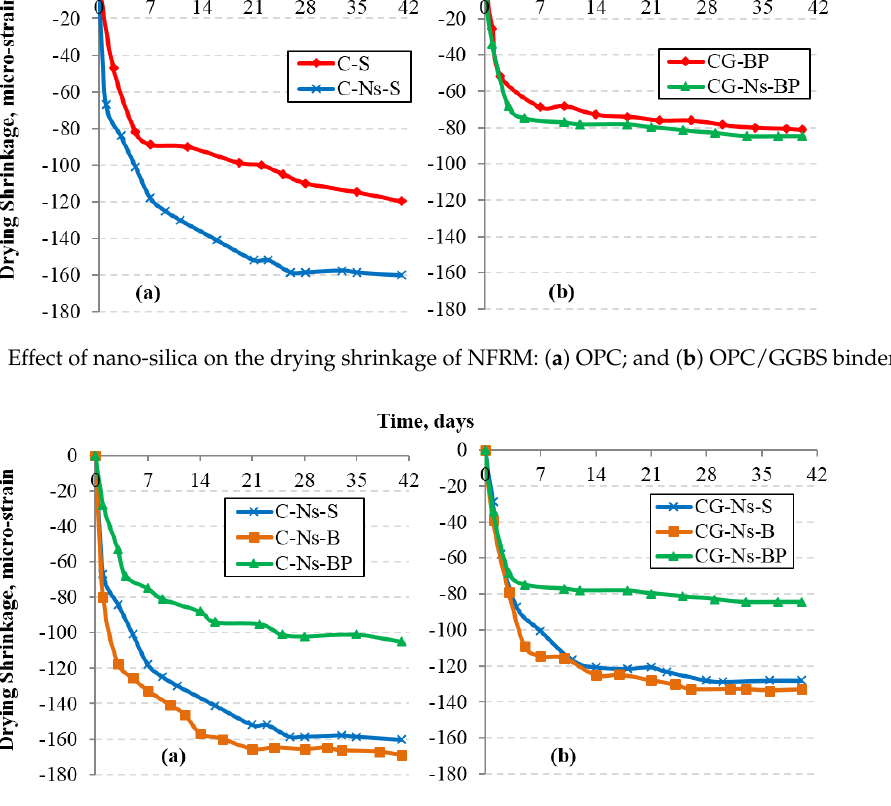
Figure 3. Drying shrinkage of the NFRM with different types of fibers: ( a ) OPC; and ( b ) OPC/GGBS binders.